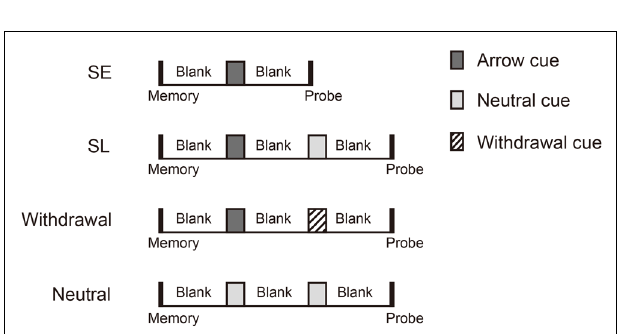
FIGURE 2 | Schematic picture of the stimulus sequence between memory array offset and probe onset for each cue type condition in Experiment